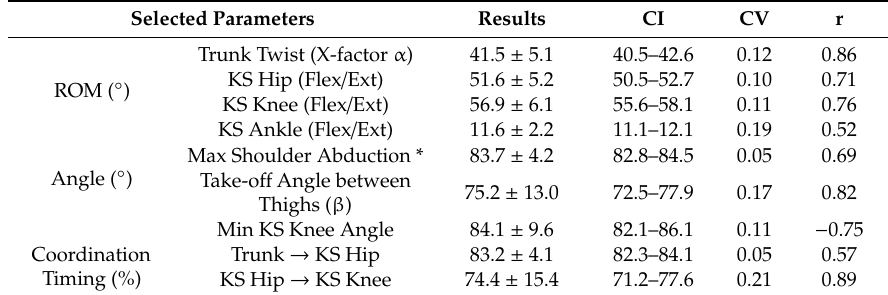
Figure 4. Phase identification based on 3D motion analysis data. Table 1. Average and standard deviation of selected parameters, their confidence intervals (CI), coefficient of variation (CV), and their correlation with the ball release speed (r) ( p < 0.05).